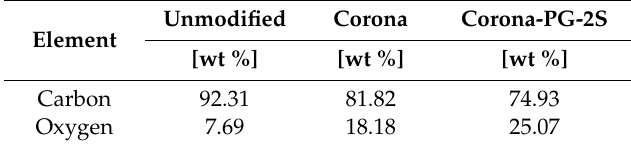
Table 4. Mass fraction of carbon and oxygen on the UHMWPE fiber surface.